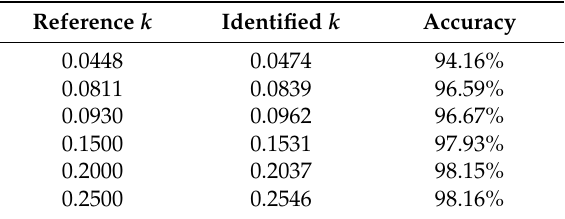
Figure 7. Identification accuracies of coupling coefficient when d varies from 0.2 to 0.9. Table 2. Coupling coefficient identification with d is 0.5, 0.6 and R b is 10 Ω .